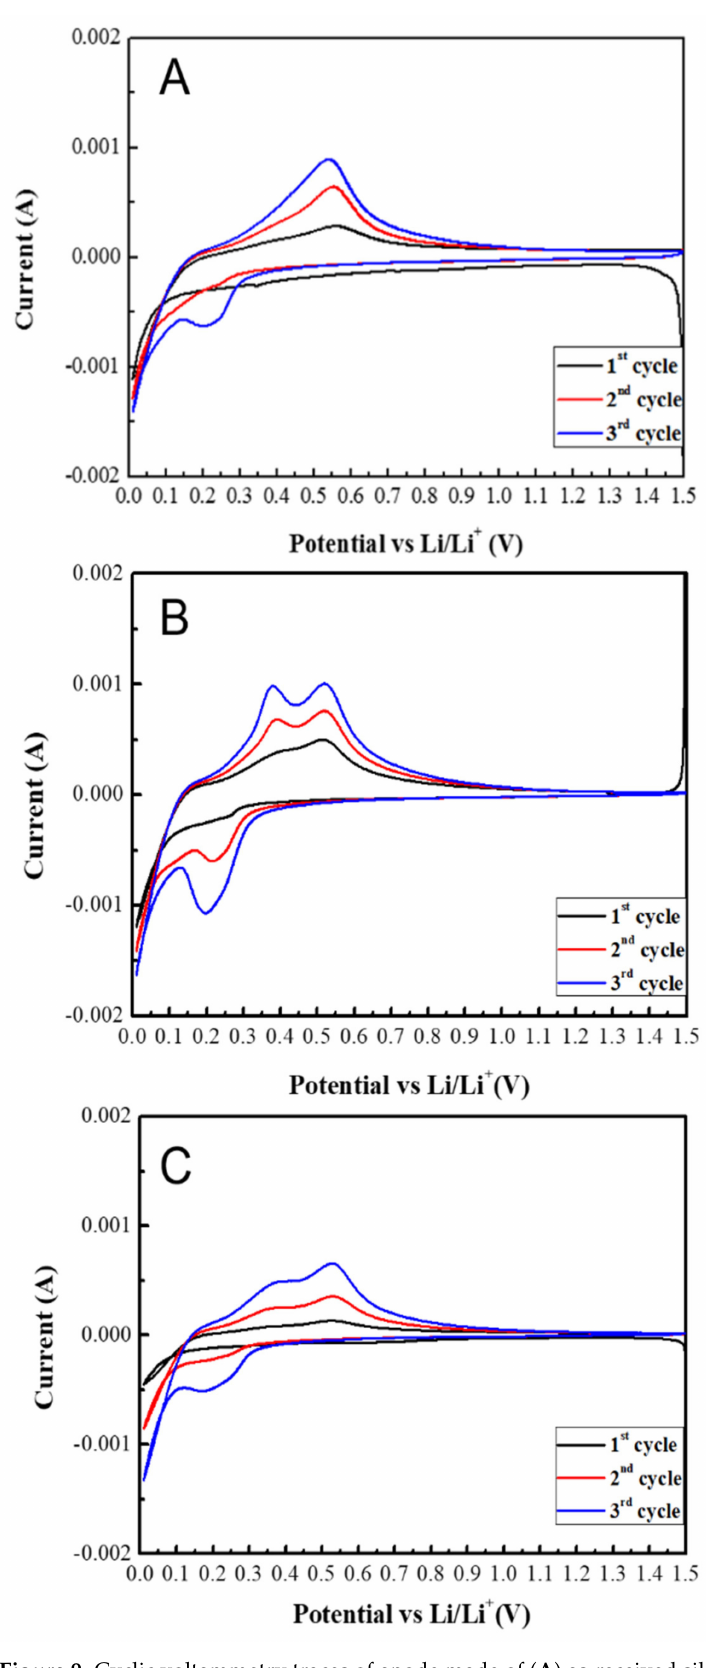
Figure 9. Cyclic voltammetry traces of anode made of ( A ) as-received silicon flakes, ( B ) silicon flakes after nanocarbon coating at 850 ◦ C, and ( C ) silicon flakes after nanocarbon coating at 650 ◦